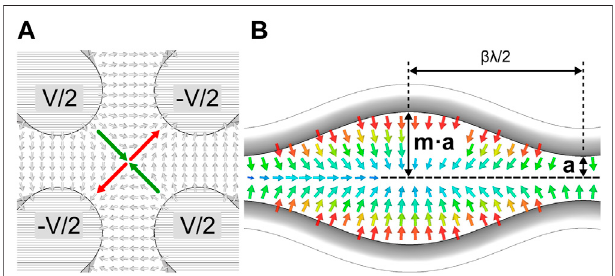
FIGURE1| Transverseelectricquadrupole fi eldaroundthebeamaxisof an RFQ (A) with focusing/defocusing plane (green/red) and electrode cell modulation (B) , resulting in a longitudinal fi eld